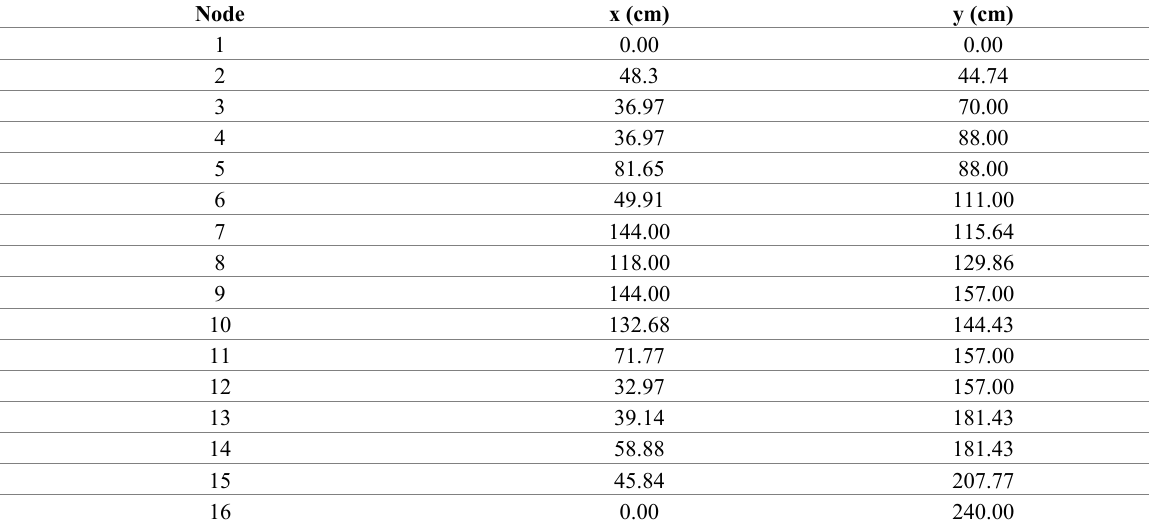
Table 6. Coordinates of truss model for f = 50%